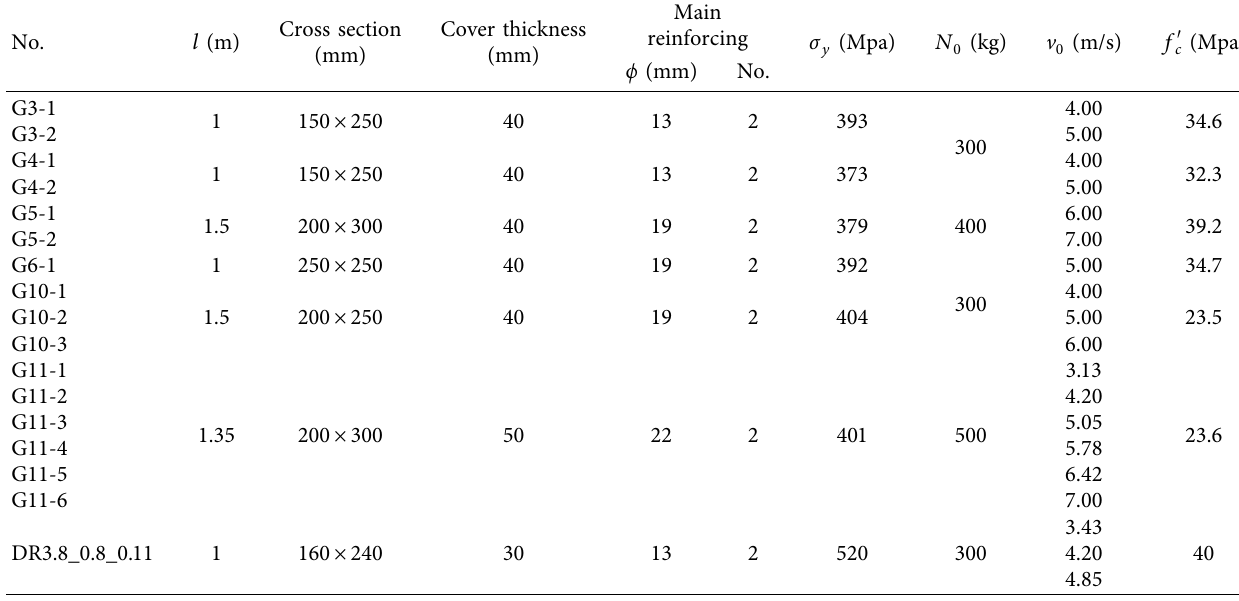
Table 1: List for geometry parameters of RC beams.